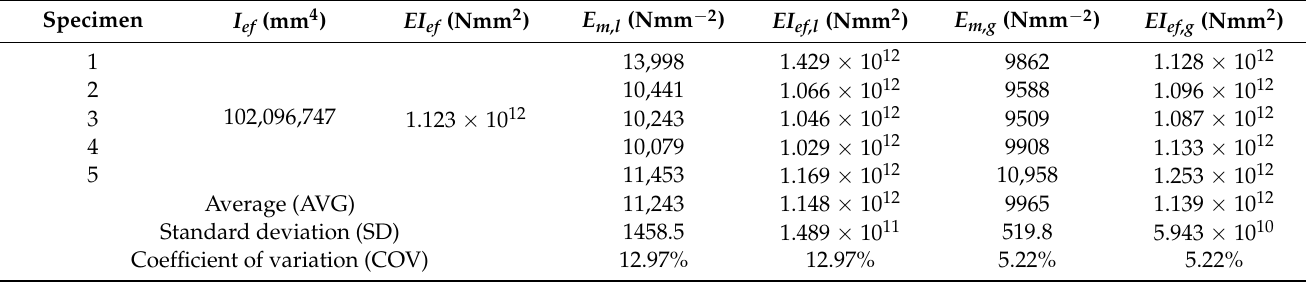
Table 4. Results of the effective moment of inertia, the moduli of elasticity and the stiffnesses in bending for CLT